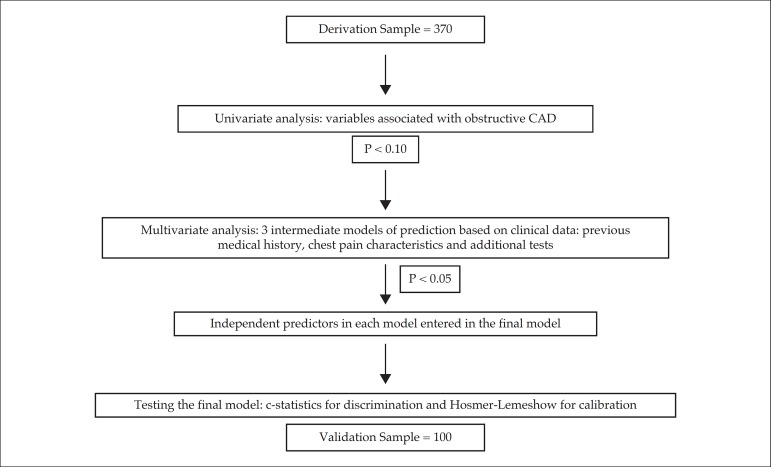
Flowchart of the statistical analysis.